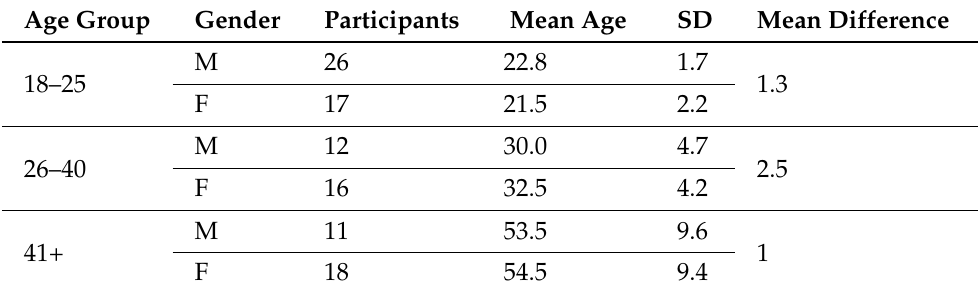
Table 1. Stratification of participants in age ranges and genders with standard deviation (SD) and absolute difference between